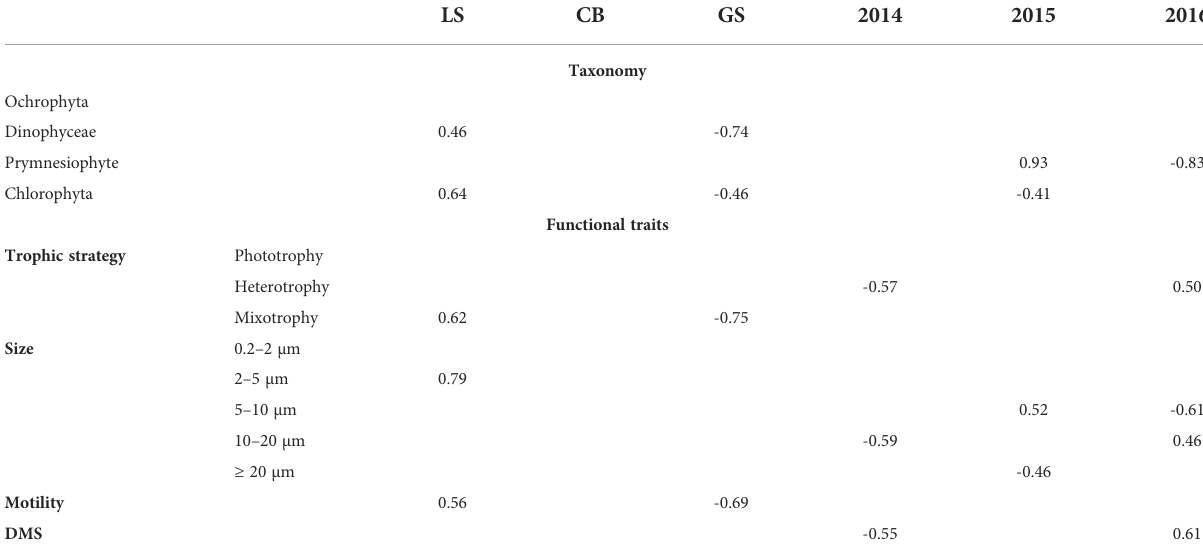
TABLE 1 Strength of the association between taxonomic groups and functional traits with water mass and year based on Pearson ’ s phi coef fi cient. Only signi fi cant associations are